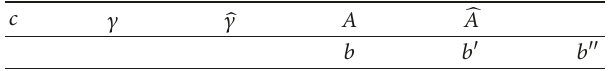
Table 1: The Butcher tableau MRKT method.